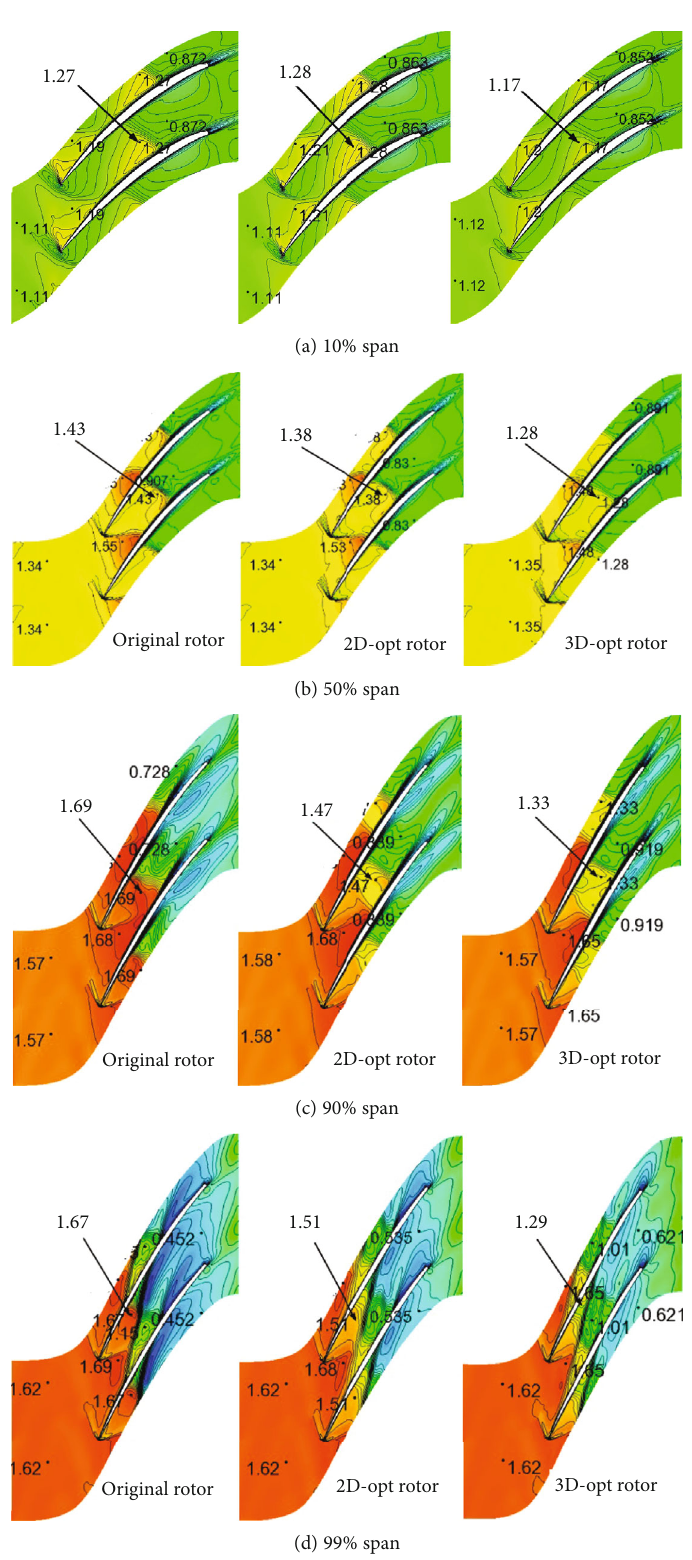
Figure 10: Mach number contours of the three rotors at the design